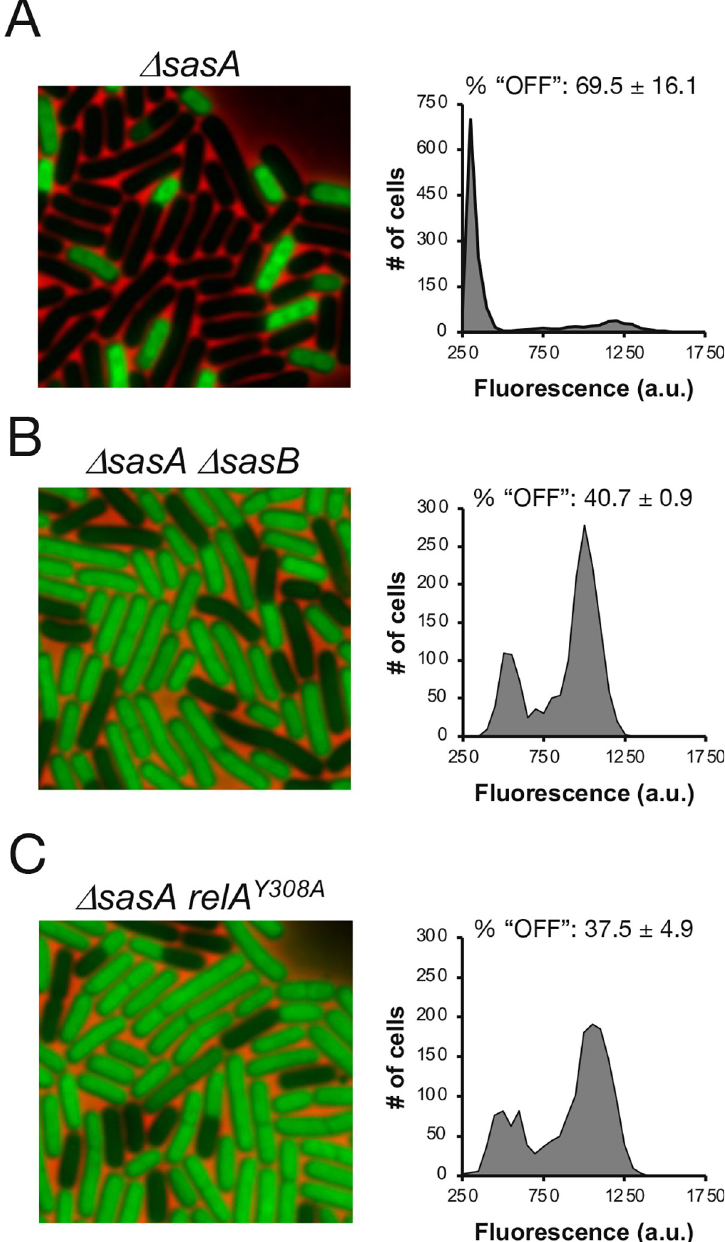
Fig 5. sasA effect is dependent on sasB and relA . (A, B, C) Representative pictures and population distributions of OPP labeled (A) Δ sasA (JDB4310), (B) Δ sasA Δ sasB (JDB4312) (C) Δ sasA relA Y308A (JDB 4301) strains during late transition phase. % of population “OFF” as defined in S1 Fig is presented above each representative distribution. Statistical significance was determined by comparing 3 independent populations of WT to either mutant. P-values are 0.028 and 0.030 for Δ sasA Δ sasB and Δ sasA relA Y308A ,